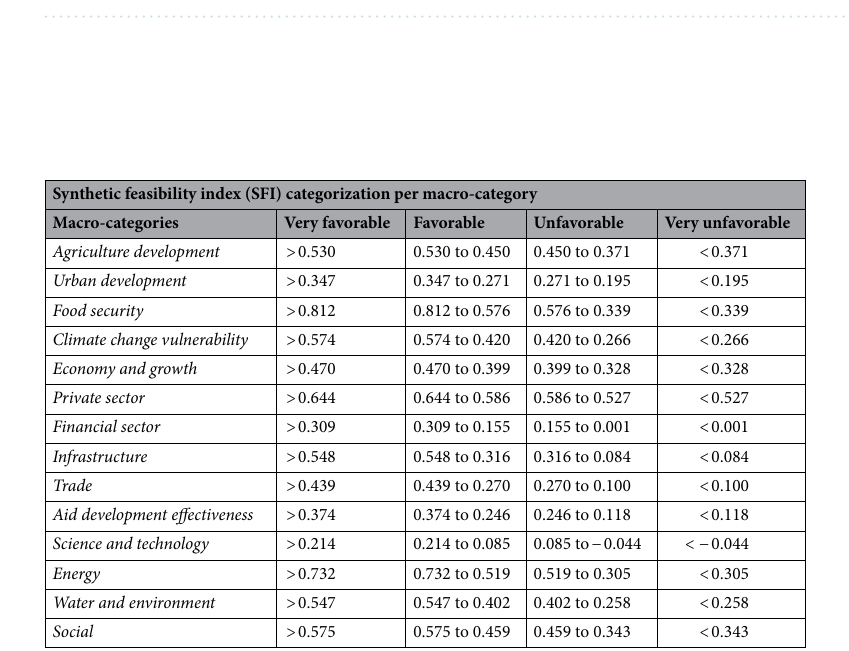
Figure 3. Categorization of vertical farming feasibility per each macro-category in African countries (generated with MapChart, https:// www. mapch art. net/).